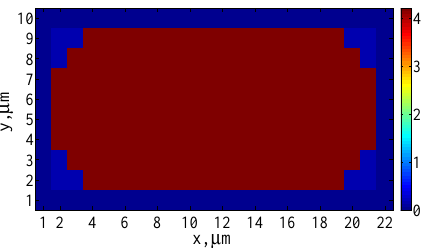
Figure 12. Distribution of w for the rectangular layer.